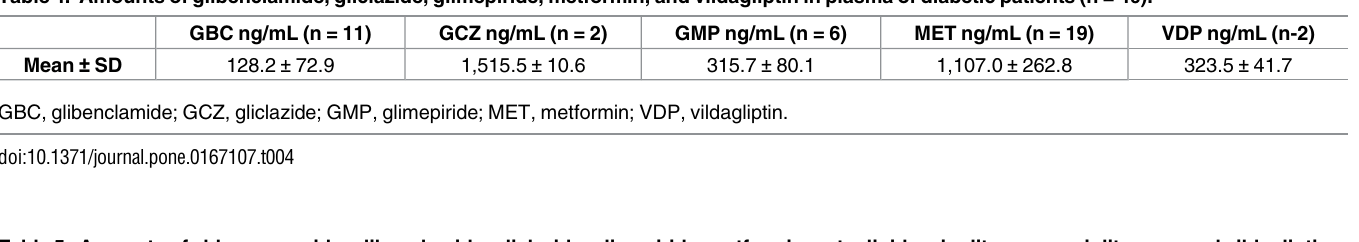
Table 5. Amounts of chlorpropamide, glibenclamide, gliclazide, glimepiride, metformin, nateglinide, pioglitazone, rosiglitazone, and vildagliptin in plasma of volunteers (n =